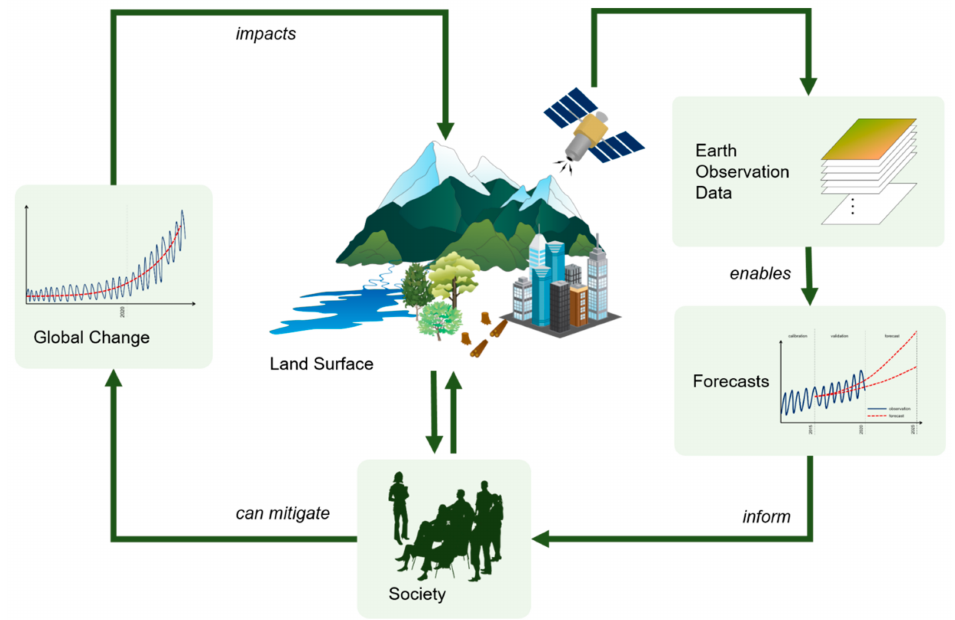
Figure 1. The relevance of Earth Observation (EO) data for the forecasting of land surface dynamics. Global change impacts the Earth’s surface in many ways. These dynamics directly a ff ect the livelihoods of people and can be monitored with remote sensing satellites which generate time series of geospatial EO datasets. These can yield valuable insight into processes on the Earth’s surface and enable forecasting. Reliable forecasts can inform policy and decision makers, planners, as well as society as a whole to take action to mitigate global change itself and its impact on the land surface. Several symbols modified courtesy of the Integration and Application Network, University of Maryland Center for Environmental Science (ian.umces.edu / symbols /